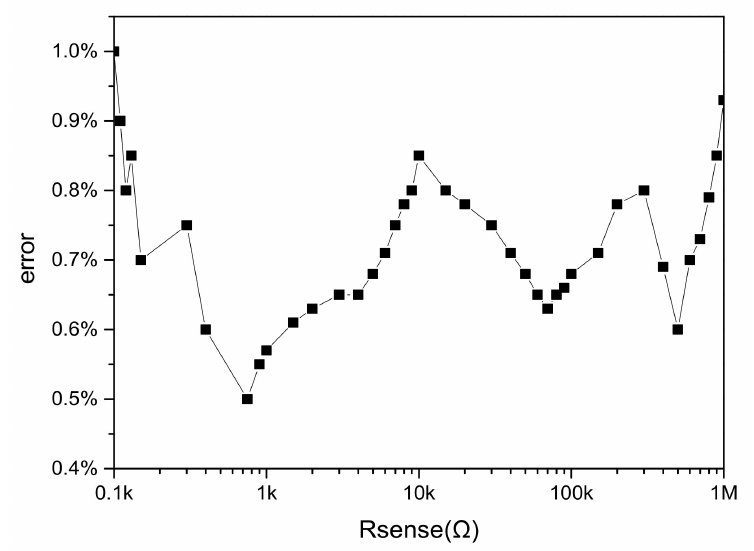
Figure 11. Simulation after system conversion error.